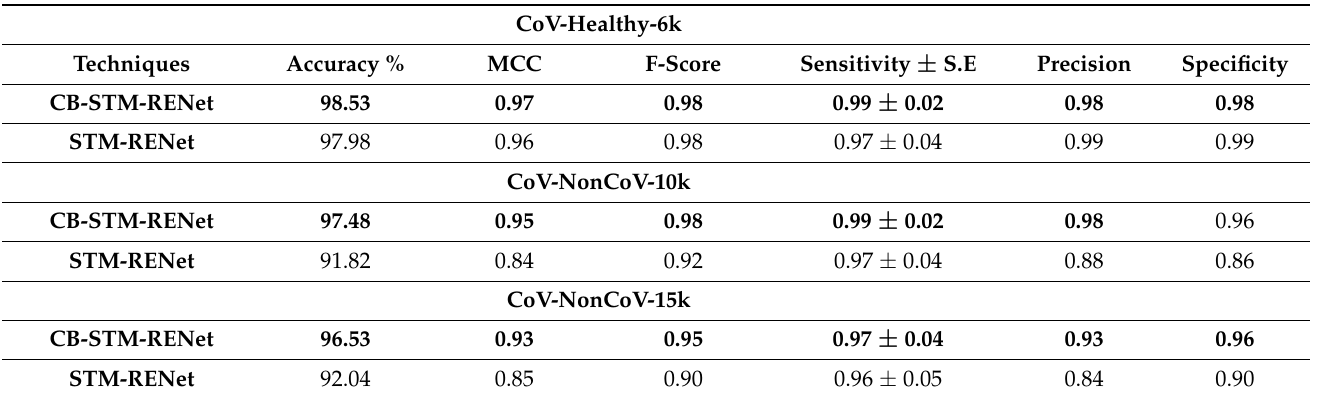
Table 1. Performance analysis of the proposed techniques on test dataset (CoV-Healthy-6k, CoV-